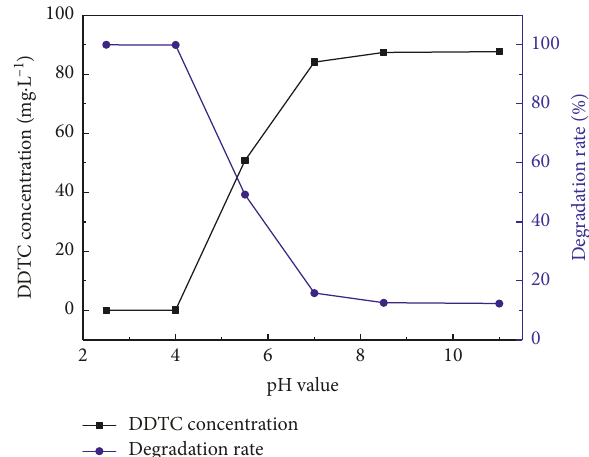
Figure 3: Influence of the pH value on the degradation of